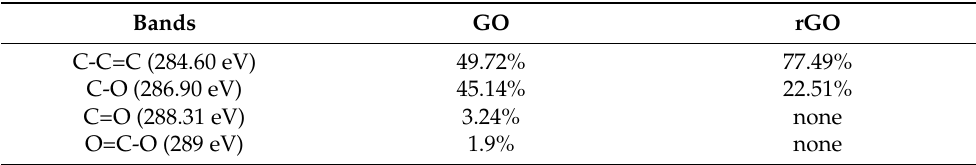
Figure 4. Characterization of materials by X-ray photoelectron spectroscopy. ( a ) XPS survey spectra of PA-PANI and PANI. ( b ) Zoom-in and fitting plot of PA-PANI’s N1s peak in XPS spectra. ( c ) Zoom-in plot and fittings of GO’s C1s peak in XPS spectra. ( d ) Zoom-in plot and fittings of rGO’s C1s peak in XPS spectra. Table 1. XPS analysis of C1s peak of GO and